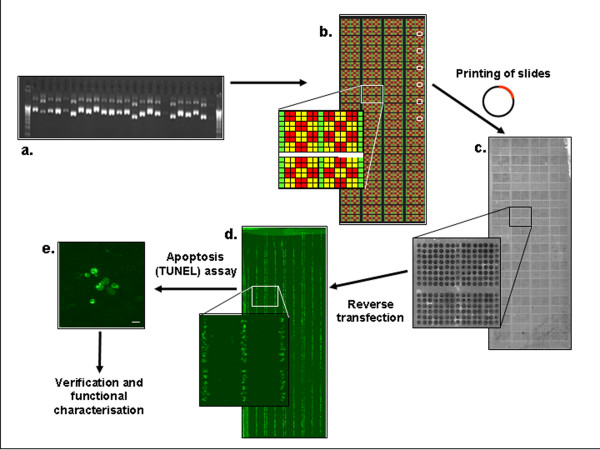
Overview of the design and use of the large-scale cell-based microarray for over-expression studies. a. Representative agarose gel image of plasmids prepared from 2,976 MGC (IRAT) clones. b. Array was designed such that each clone was printed in quadruplicate (yellow and red squares) surrounded by columns of GFP vector (green squares). The position of GFP-tagged positive control genes is shown by small white boxes. c. 1,959 plasmids in 0.3% gelatin were printed on to a glass slide in to form an array with 9,888 features. The image is of an array scanned directly after printing (Agilent microarray scanner). d. An array cultured with HEK293T cells and scanned with a fluorescent imager (GE Healthcare, Typhoon) to show lines of GFP positive cells. e. Arrays were subjected to a functional assay to detect changes in the cell after over-expression of proteins. The image is of TUNEL positive cells, scale bar = 10 μm.